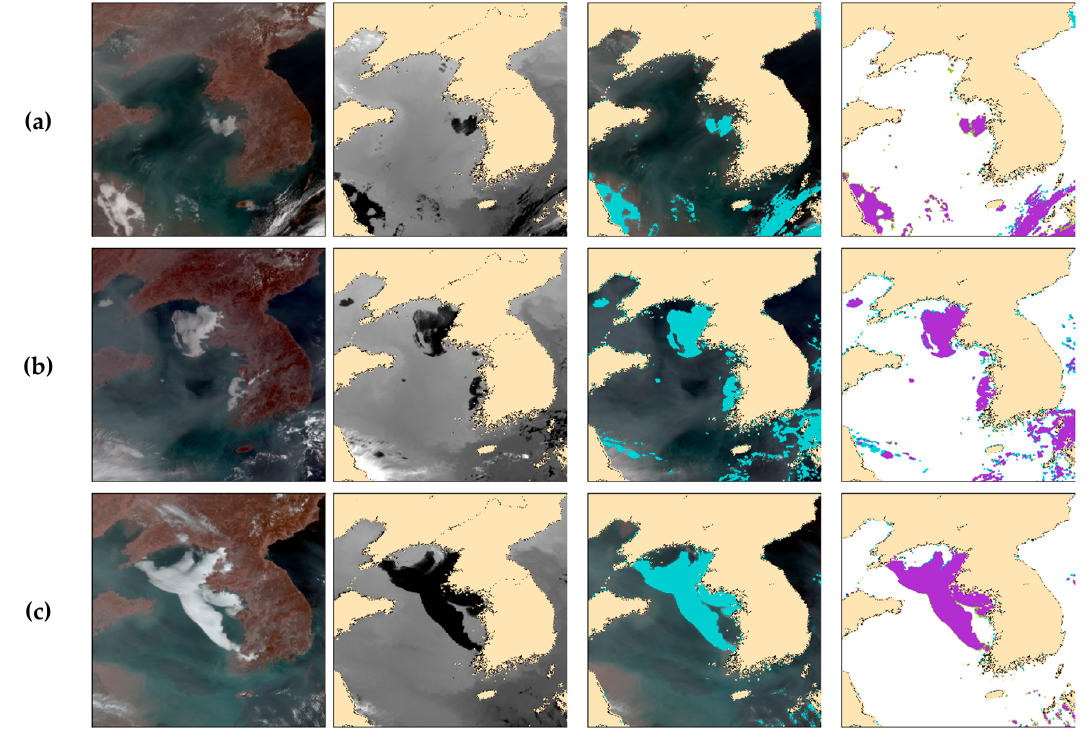
Figure 8. Quantitative comparison of the proposed sea fog detection algorithm and AHI BTD sea fog algorithm. POD, PAG, CSI, and HSS values were 0.954, 0.113, 0.851, and 0.911, respectively.